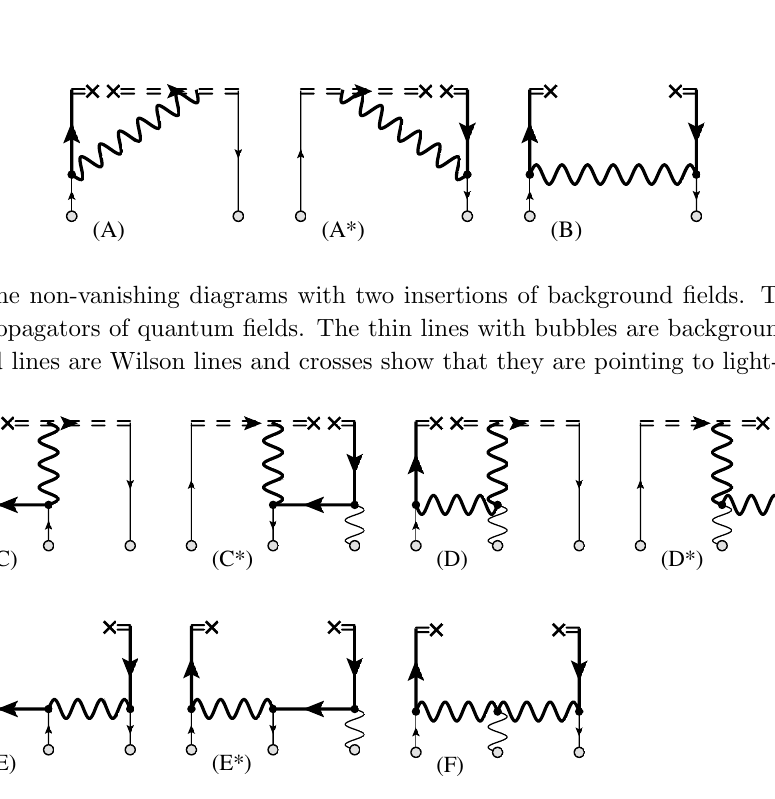
Figure 4 . The non-vanishing diagrams with three insertions of background (cid:12)elds. The bold lines denote the propagators of quantum (cid:12)elds. The thin lines with bubbles are background (cid:12)elds. The double dashed lines are Wilson lines and crosses show that they are pointing to light-cone